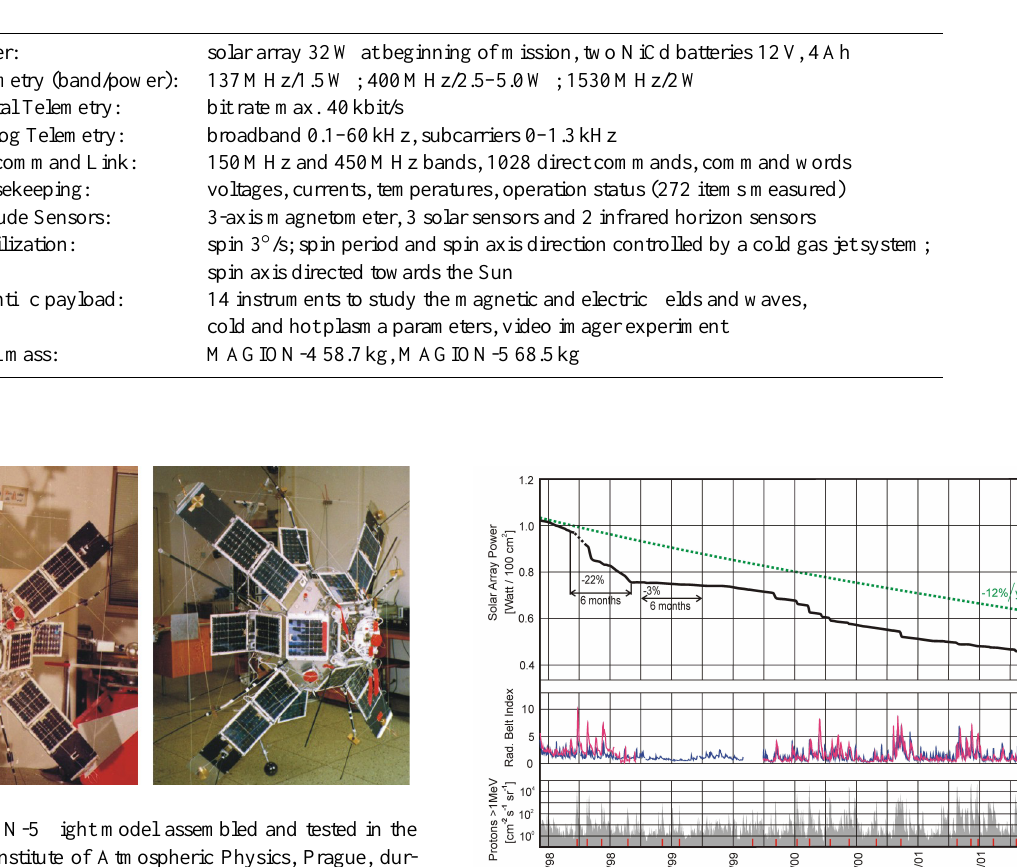
Table 1. MAGION S/C subsystems.